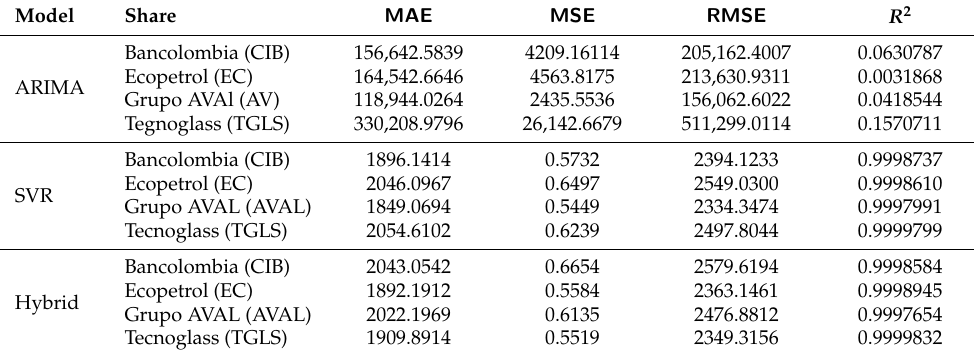
Table 7. Accuracy metrics and R 2 for daily returns an all models. The figures in the MAE , MSE , and RMSE columns are to be multiplied by 10 − 7 .